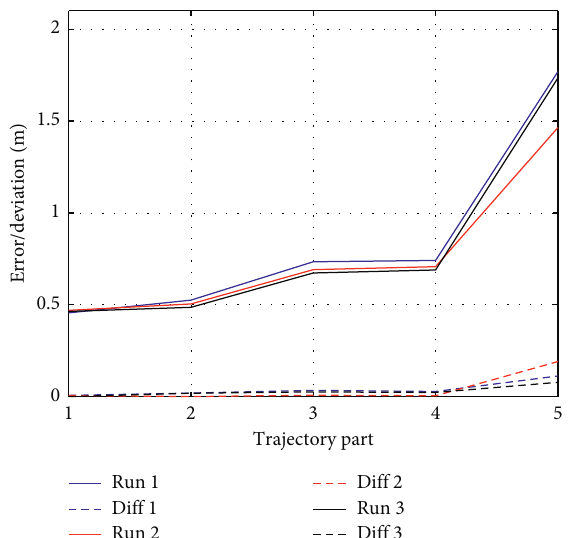
Figure 15: The difference between the UWB and RTK-SN positions for the three reruns of the experiment shown in Figure 14. The dotted lines show the difference from each individual test to the average, indicating the